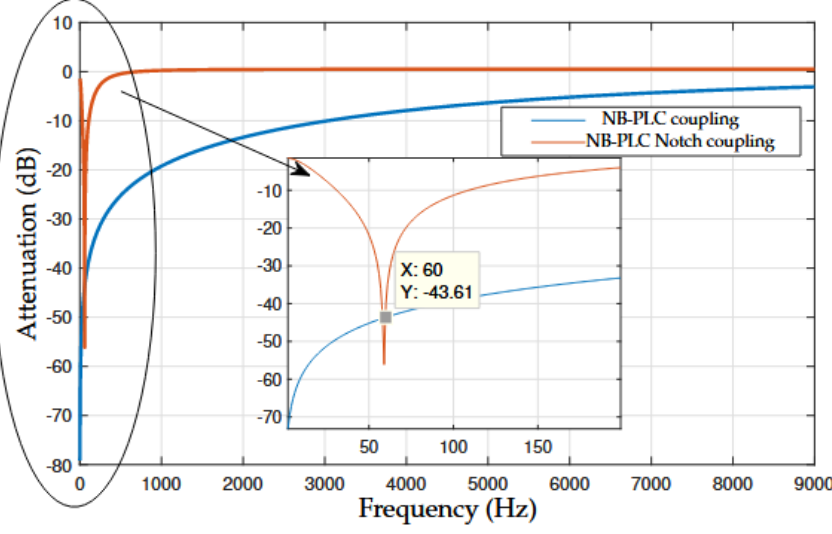
Figure 6. Attenuation comparison between NB–PLC notch coupling circuit and NB–PLC capacitive coupling circuit.